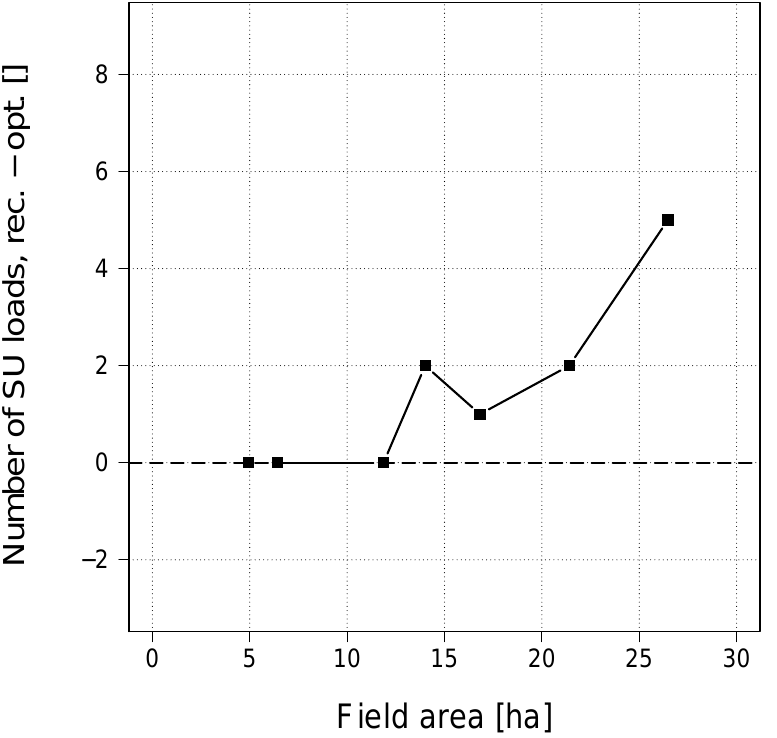
Figure 8. The difference ( (cid:110) ) between the number of recorded SU loads and the number of SU loads optimised by the coverage path planning method in relation to field size. A difference (y-axis) is calculated per field by subtracting the number of SU loads derived from the recorded data and the number of SU loads derived from the simulated optimised route plan data. The dashed horizontal line at zero on the y-axis indicates whether the optimised route planning provided an increase or decrease in the number of SU loads compared to the recorded data, indicated by a negative or positive number of loads, respectively, in the